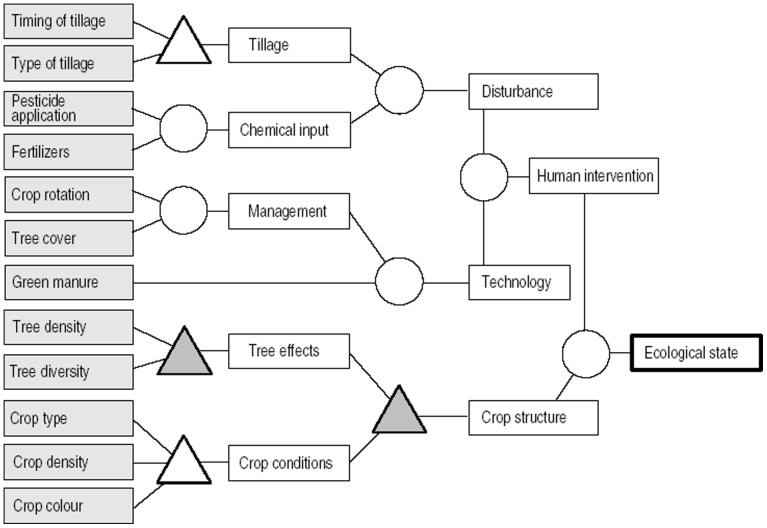
Structure of the Index of ecological condition of tropical agroecosystems.Primary indicators are shaded in grey. Circles represent simple mathematic algorithms, white triangles represent rule sets, and grey triangles represent rule sets, and grey triangles represent rule sets based on fuzzy logic. This index was presented together with other indexes within a frame of Indicators of environmentally sound land use in the humid tropics [15].